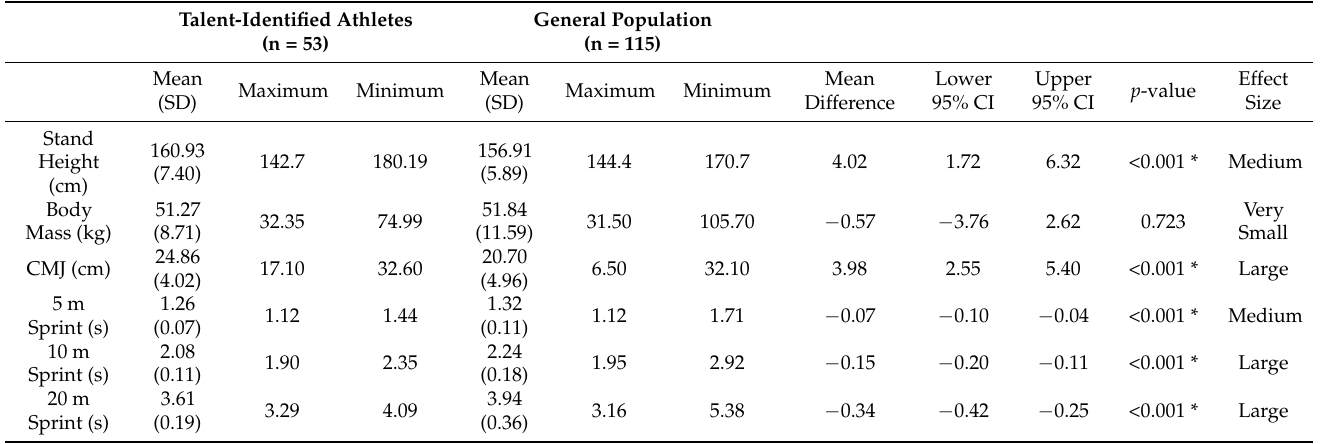
Table 1. Descriptive statistics with group difference for female talent-identified athletes and the general population counterparts for the physical performance